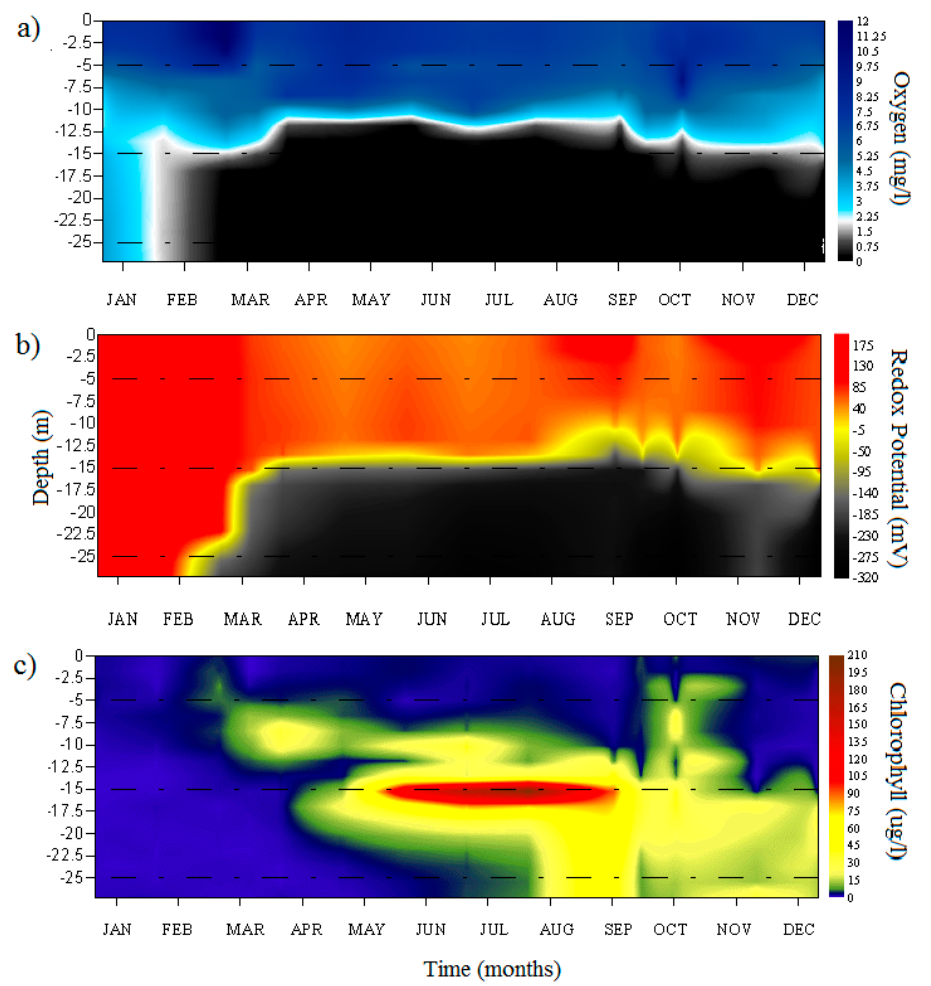
Figure 2. Dissolved oxygen ( a ), redox potential ( b ) and chlorophyll ( c ) profiles during 2010 along the water column.